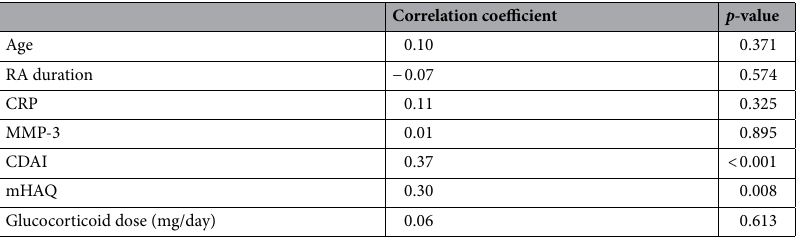
Table 4. Correlation of clinical parameters at drug administration and yearly progression of erosion score at 12 months after drug administration. RA rheumatoid arthritis, CRP C-reactive protein, MMP-3 matrix